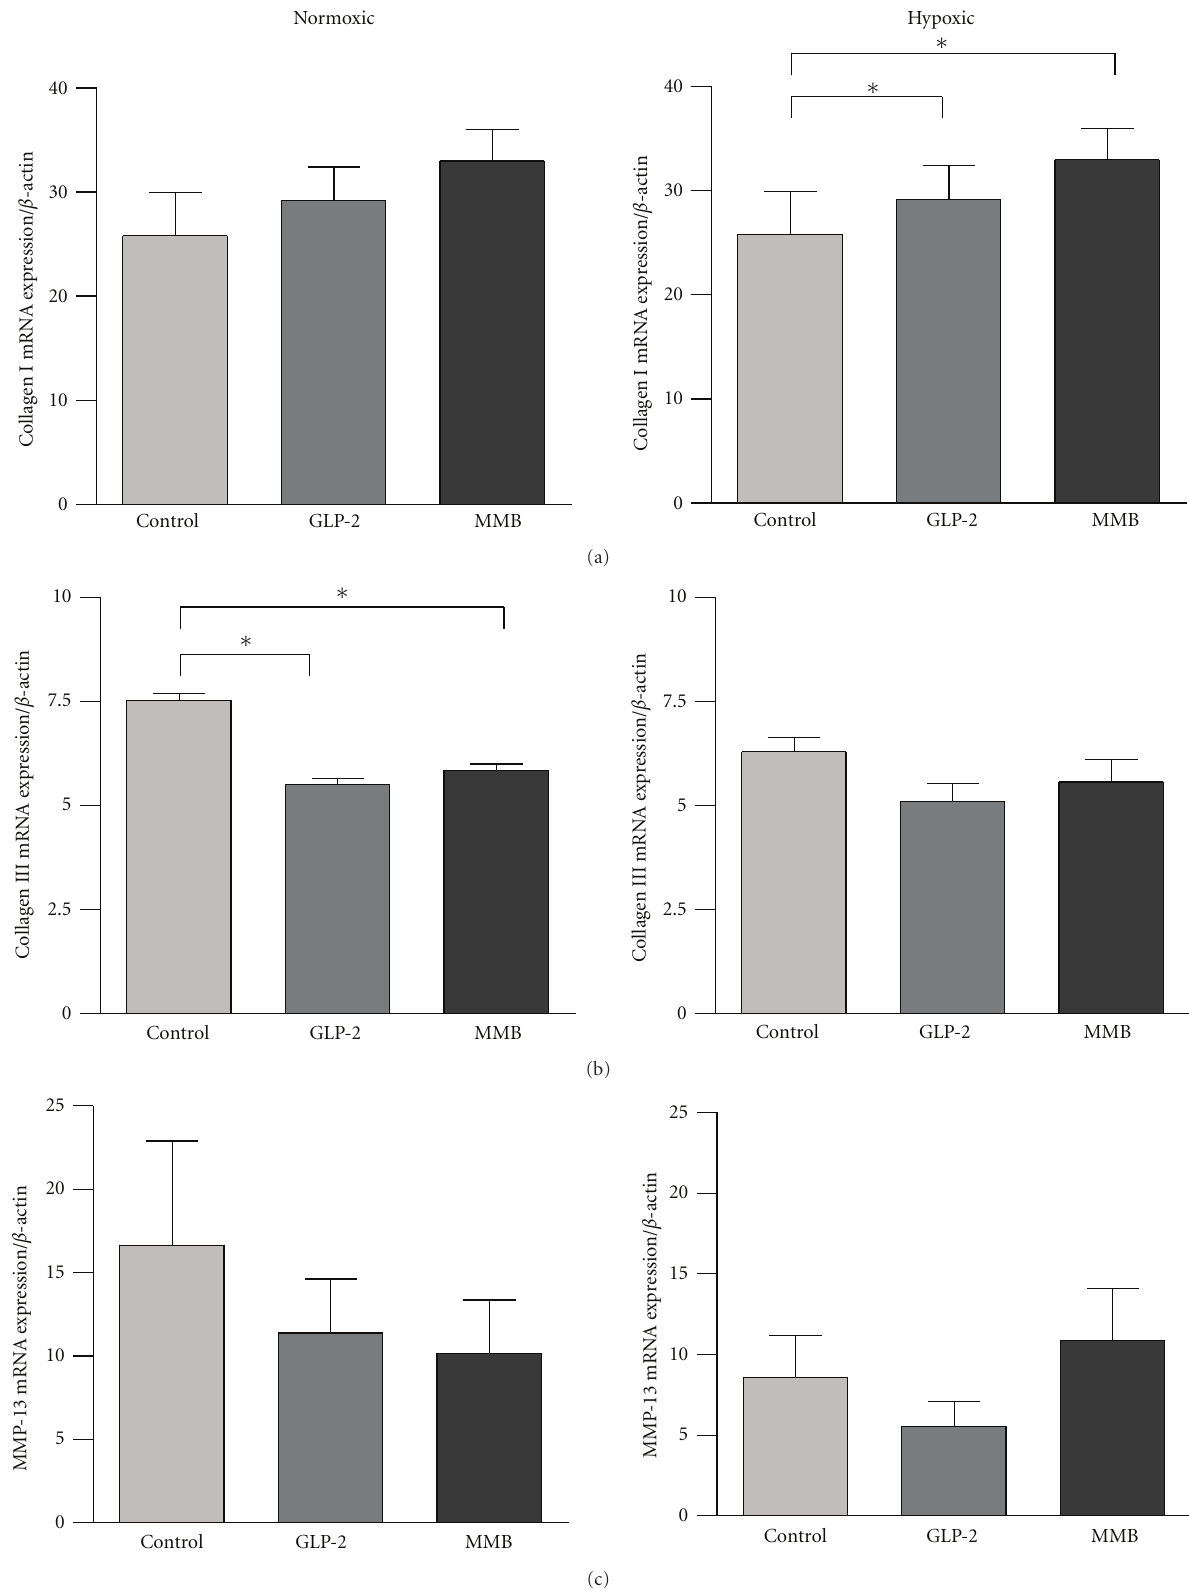
Figure 6: RT-PCR analysis of collagen and collagenase (MMP-13) mRNA Levels. mRNA expression of collagen I (a), collagen III (b), and matrix metalloproteinase 13 (c) in anastomotic tissue, as measured by RT-PCR normalized to β -actin. Data: mean ± SEM, n = 7 or more per group, ∗ P < . 05 versus the group indicated, by